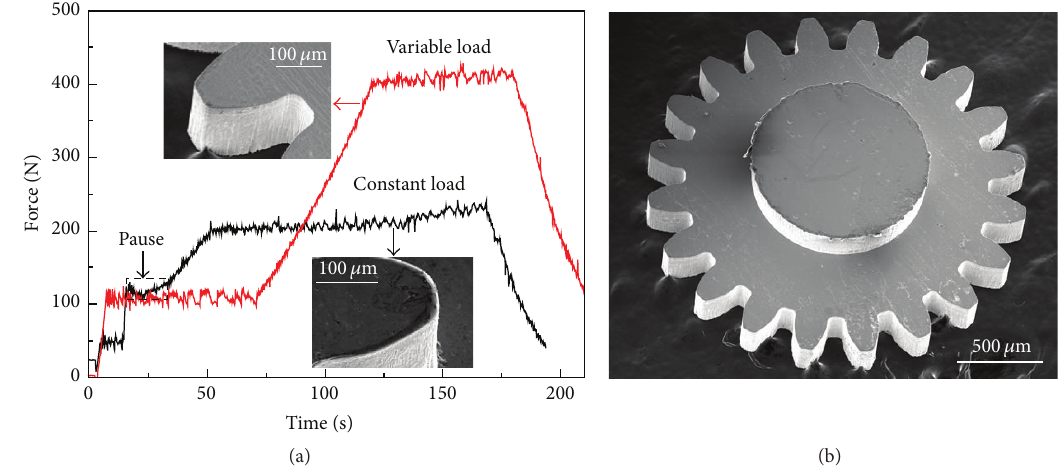
Figure 6: The experimental results. (a) True force curves for the two load modes with the details of the microgear teeth in the insets, (b) SEM image of the microgear formed under the varying load.